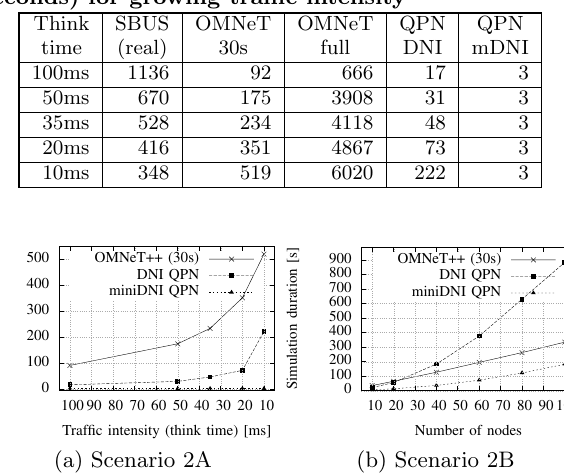
Table 5: Scenario 2 B : transformation and model solution duration (in seconds) for growing